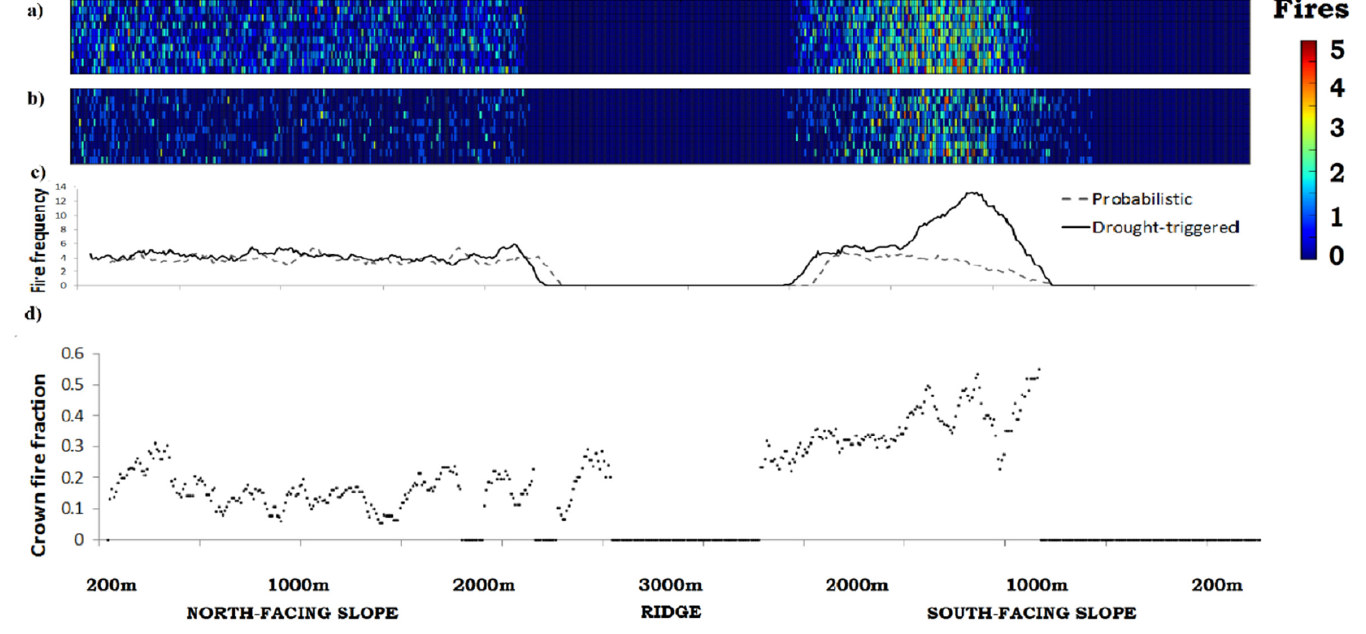
Figure 5. Location and frequency of fire along an idealized mountain with climate and edaphic conditions from southern Siberia: ( a ) probabilistic MFRI-based fire regime with historical climate; ( b ) drought-triggered fire regime with historical climate; ( c ) comparison of fire frequencies along an elevational gradient on north- and south-facing slopes (frequency in plot-sized fires per hectare per century); ( d ) crown fire fraction along an elevational gradient on north- and south-facing slopes under a warming scenario. The fire is randomly distributed across the forested landscape under a probabilistic fire regime, but with a drought-trigger spatial patterns appear in the locations and frequency of fire across the landscape, and most of the crown fires are concentrated on the south-facing slope, with maximum crown:ground fraction approaching 50%. The color bar for (a,b) represents the number of- a plot has burned over the course of a 100-year simulation. Each grid cell represents one 10 m × 10 m plot.